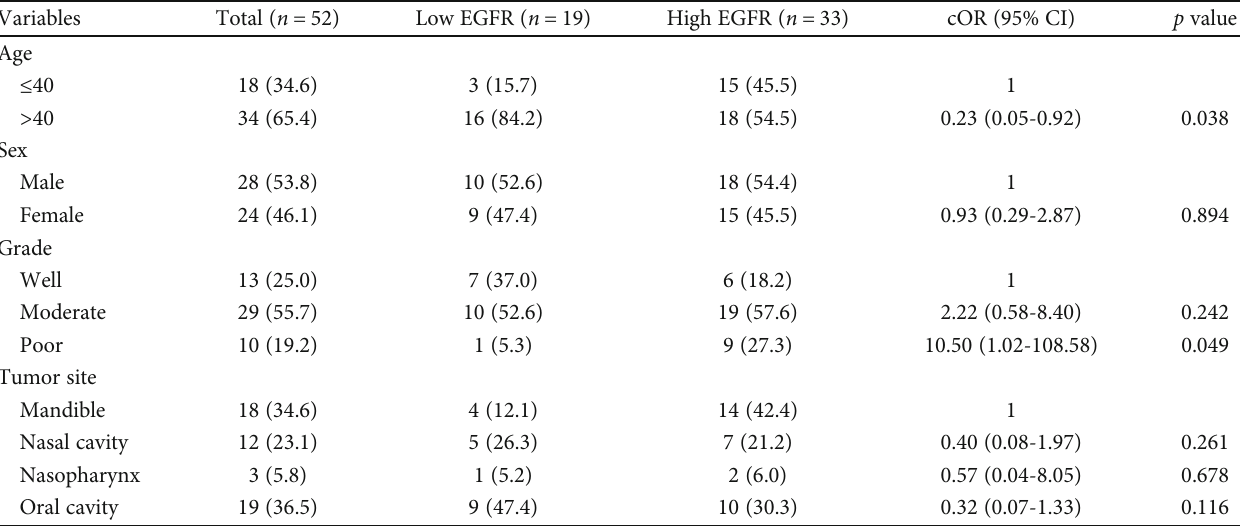
Table 2: Association between EGFR and clinicopathologic characteristics in patients with head and neck benign